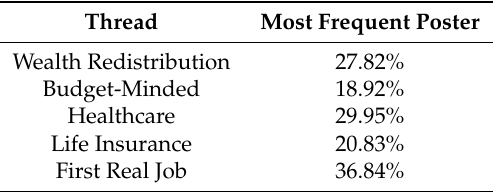
Table 3. Contribution of most frequent